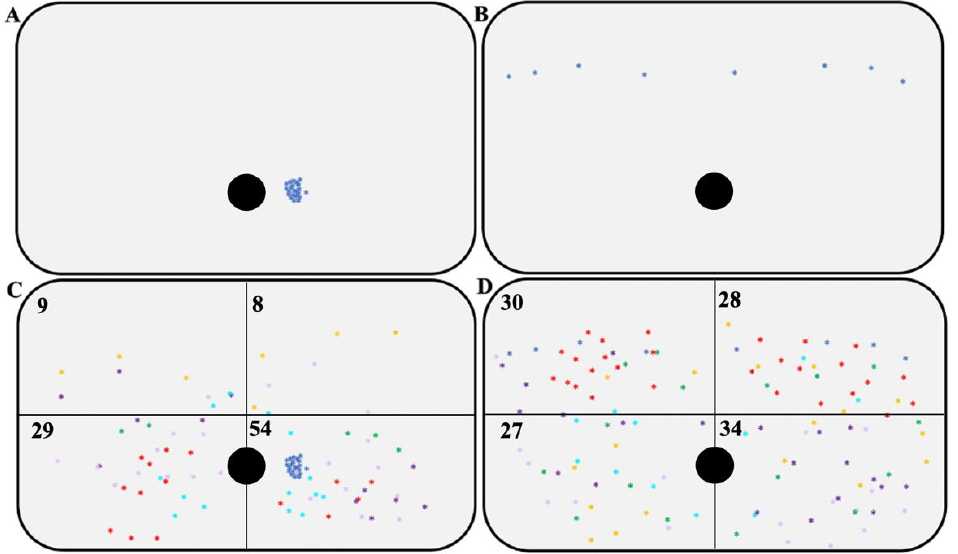
Figure 6. The distribution of self-injection sites. ( A ) Distribution of self-injections by a case belonging to the IARA one week after T0; ( B ) Distribution of self-injections by the same case in A at 12 months follow-up (T3); ( C , D ) Distribution of self-injections of IARA one week after T0 ( C ), and at 12 months follow-up (T3; ( D )). Numbers at the corner represent the self-injections in that part of the abdomen, and it is possible to observe the most homogeneous distributions of self-injections at T3 rather than T0.